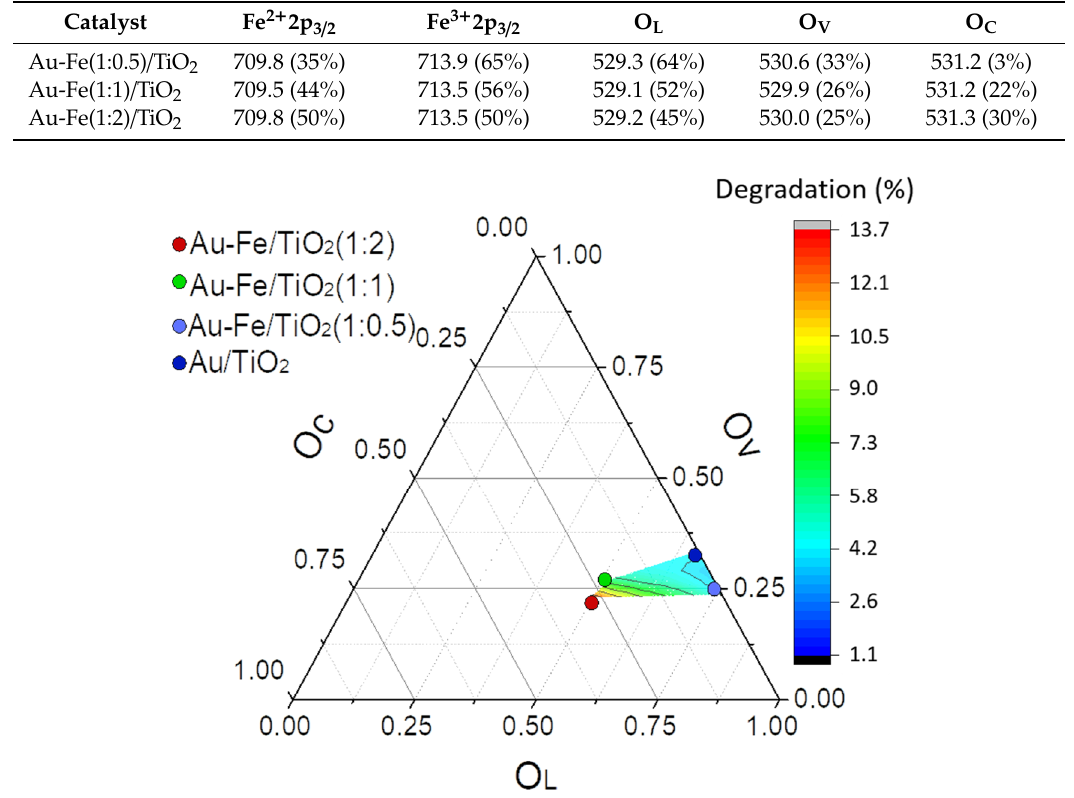
Figure 6. Relative concentrations of lattice oxygen species (O L ), oxygen vacancies or defects (O V ), and chemisorbed or dissociated oxygen species (O C ) on the catalyst surface together with the degree of degradation achieved after 30 min under UV radiation. Degradation % = 100% (A 0 − A 30 ) / A 0 , where A 0 and A 30 are the absorptions at times 0 and 30 min, respectively (cf. Figure 4).